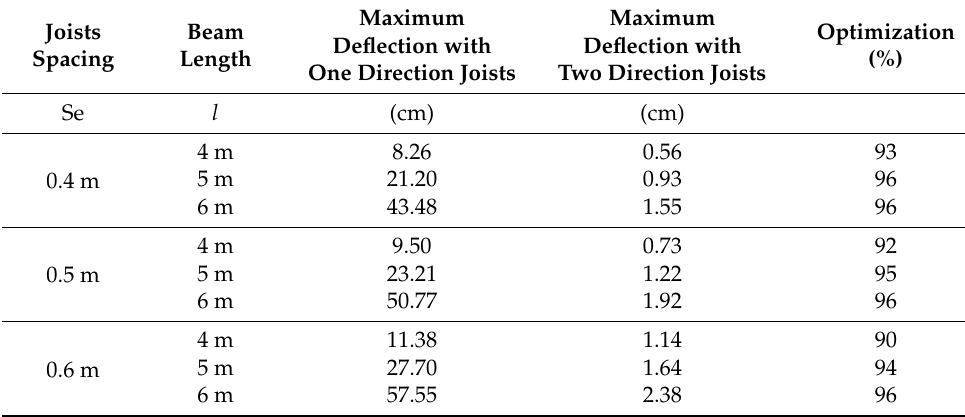
Table 10. Maximum deflection of shell with one